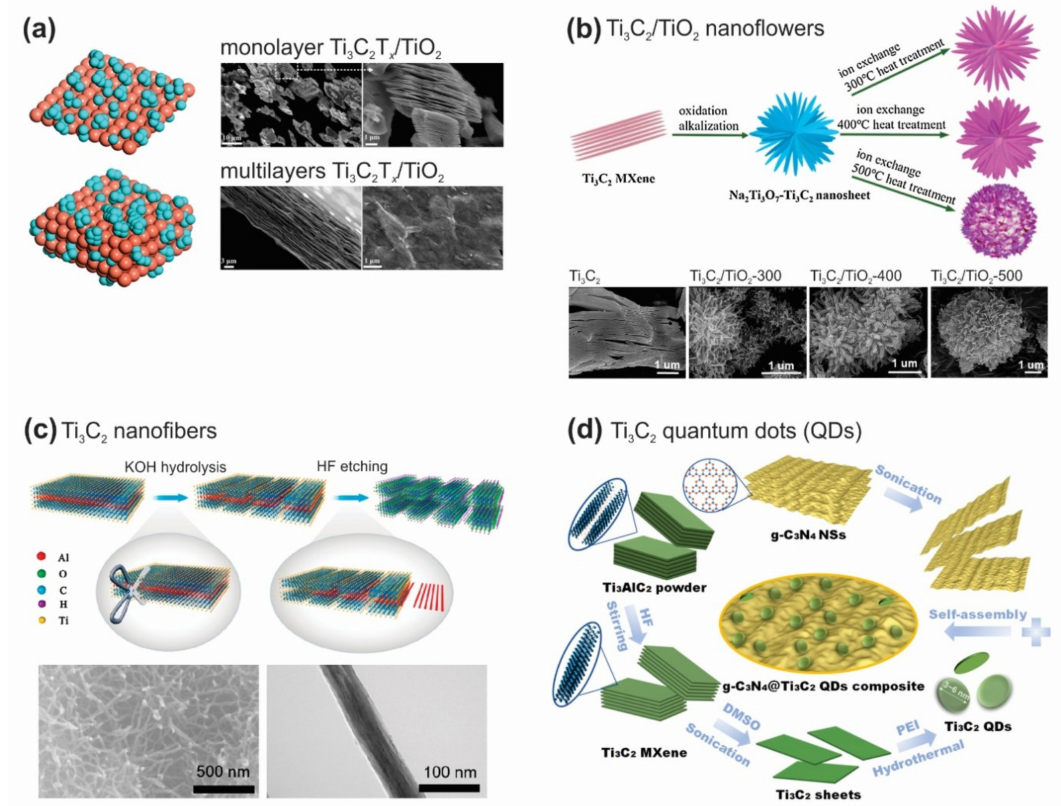
Figure 4. ( a ) Monolayer and multilayers Ti 3 C 2 T x as the cocatalysts. Reproduced with permission from reference [52]. Copyright American Chemical Society, 2019; ( b ) the preparation of Ti 3 C 2 T x / TiO 2 nanoflowers and their corresponding SEM images. Reproduced with permission from ref. [53]. Copyright Nature Publishing Group, 2018; ( c ) the preparation of Ti 3 C 2 T x nanofibers and their corresponding SEM, TEM images. Reproduced with permission from ref. [54]. Copyright American Chemical Society, 2018; and ( d ) Schematic diagram for preparing of g–C 3 N 4 @Ti 3 C 2 T x quantum dots composites. Reproduced with permission from ref. [55]. Copyright American Chemical Society,